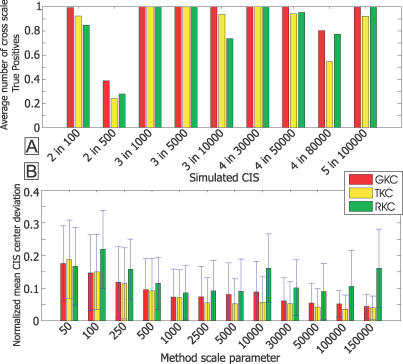
Results from Simulation Experiments—Cross Scale True Positives and Deviations from CIS Center(A) Average number of csTPs per artificially generated CIS. Significant errors are made for the borderline cases: the narrow CISs (500 bp), or broad CISs (80k bp) with relatively few insertions. The GKC outperforms the RKC and TKC for all simulated CISs.(B) Average deviation of the detected CIS center from the actual simulated CIS center normalized on the simulated CIS width plus the scale parameter under consideration.